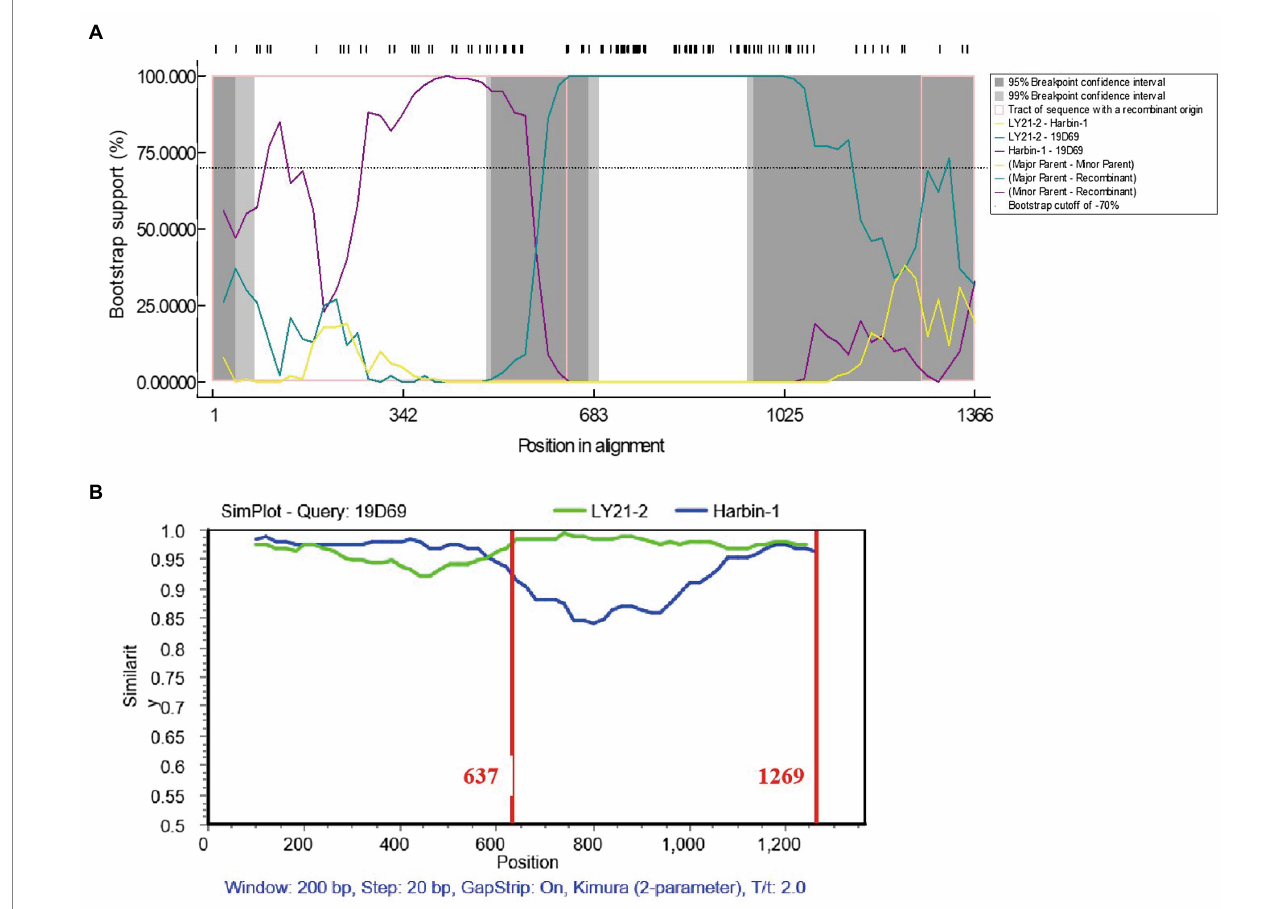
FIGURE 3 Recombination event of the variant IBDV strain LY21/2. (A) Comparisons of the similarity of 19D69 VP2 gene scales with LY21/2 (cyan) and Harbin-1 (purple) were calculated by RDP4 v4.5. The strain LY21/2 was the major parent and the strain Harbin-1 was the minor parent. (B) The recombination breakpoints were determined by using Simplot v3.5 and located at nt 637 and nt 1,269, respectively. The major parent (LY21/2) is shown in green, and the minor parent (Harbin-1) is shown in blue. The recombination breakpoints are both exhibited as vertical